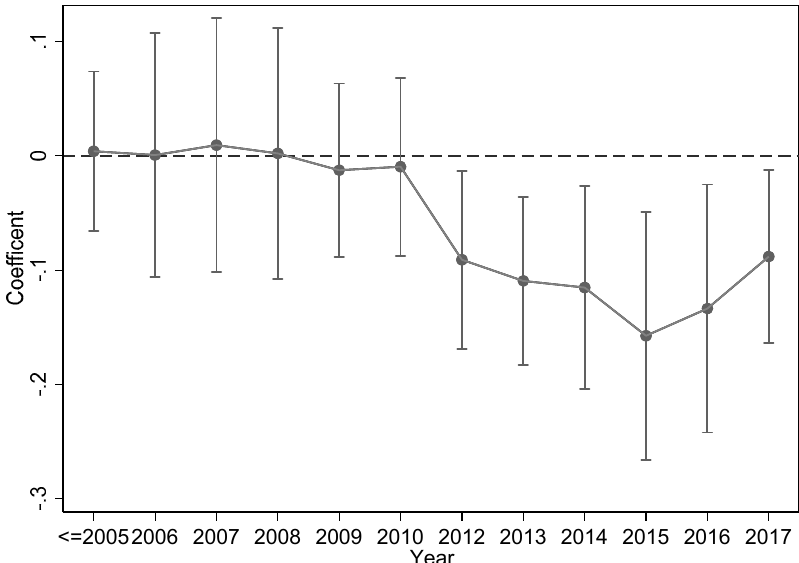
Figure 2. Dynamic effects of the City Cluster.